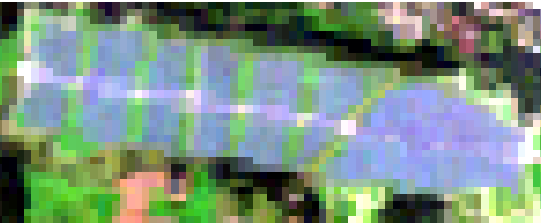
Figure 2: DESIS true color composite: bands 94 (640 nm), 59 (550 nm), 24 (470 nm).